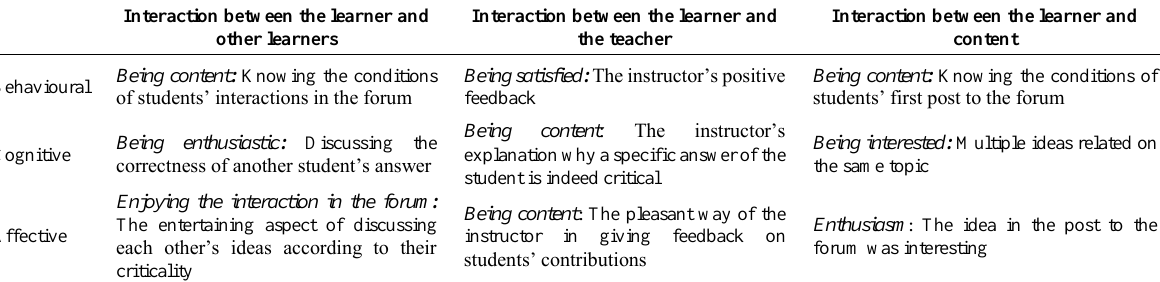
Table 9. Occurrences in forums that resulted in a positive affective engagement.